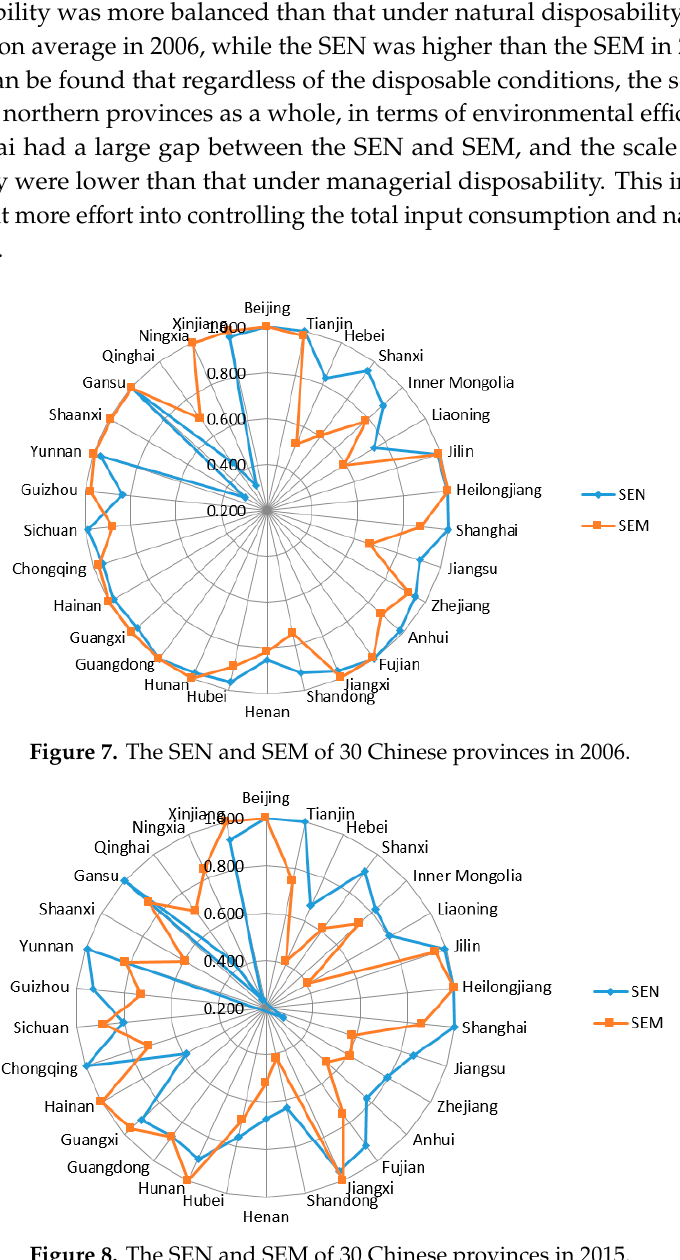
Figure 8. The SEN and SEM of 30 Chinese provinces in 2015.